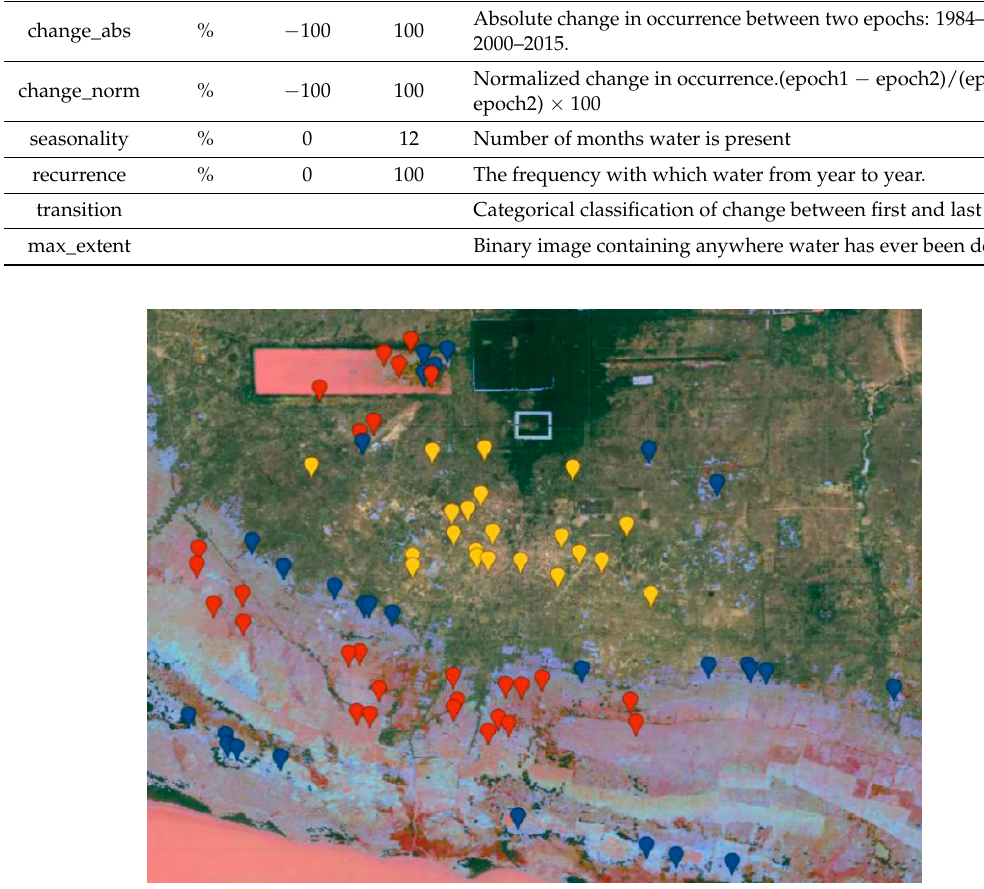
Figure 10. The locations of 28 points in high hazard zones (red), moderate hazard zones (blue), low hazard zones (yellow).